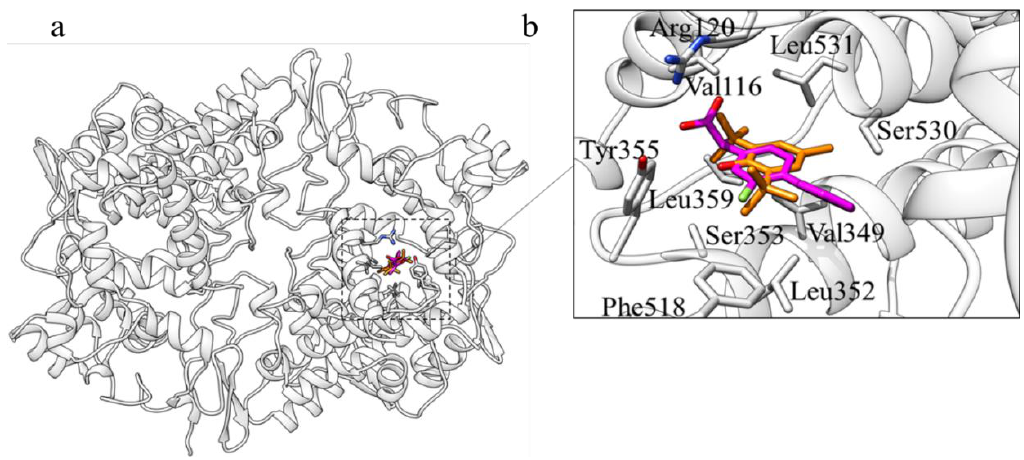
Figure 3. The best docking pose for BHT (orange) binding to COX-1 superimposed with the co-crystallized ligand, FLP (magenta). Protein residues are coloured by atom type, carbon atoms in grey. ( a ) Overall view; ( b ) detail of the binding pocket.